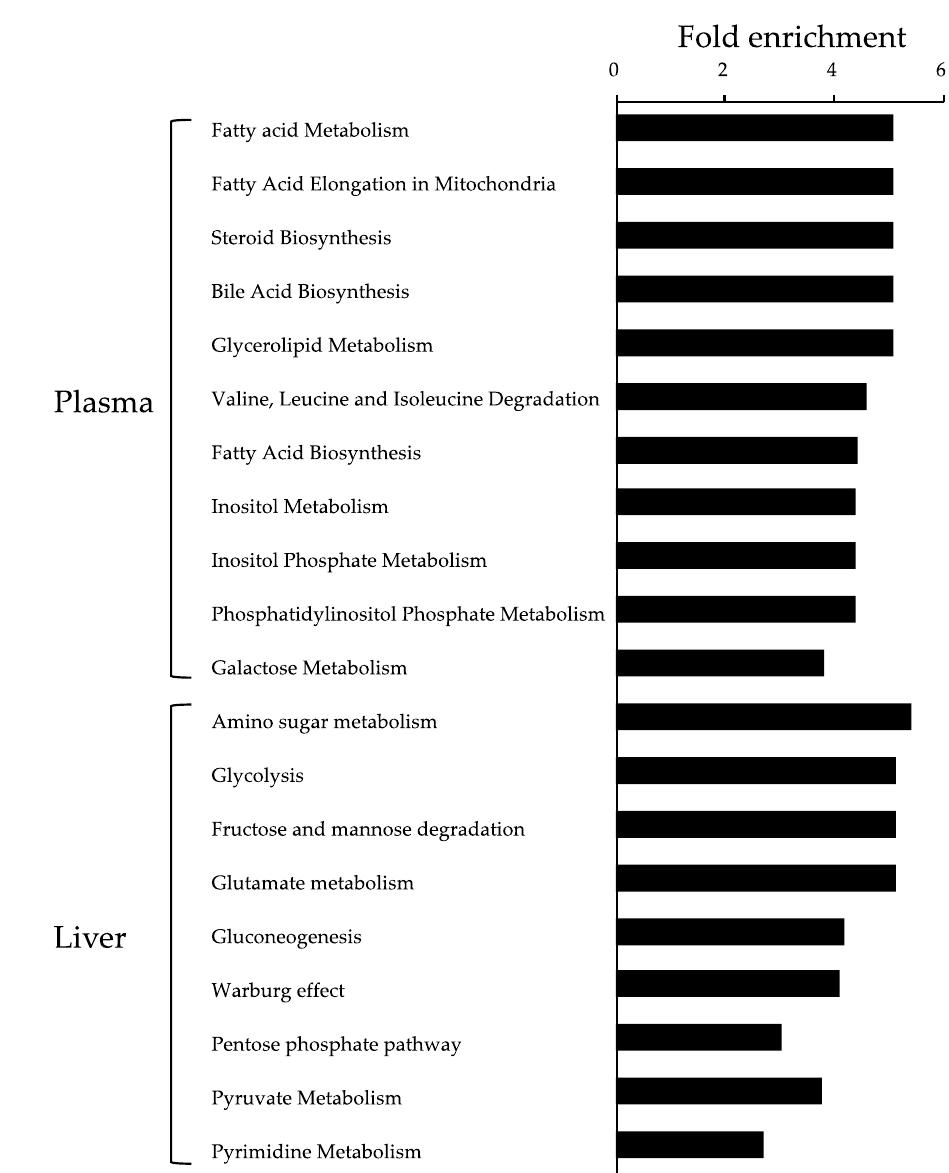
Figure 1. Global changes in metabolite abundance in the plasma and livers of rats fed the OBFR diet. ( A ) The number of metabolites in the plasma and liver. ( B ) The relative abundance of 35 metabolites that were detected in both the plasma and liver, shown as a heat map. The content of each metabolite is shown as a log 2 value, with the log 2 value of the control group set to zero. ( C ) The metabolic pathways significantly affected by feeding OBFR, as determined through the enrichment analysis of metabolites which differed significantly in abundance between the groups. OBFR, outer bran fraction of rice.